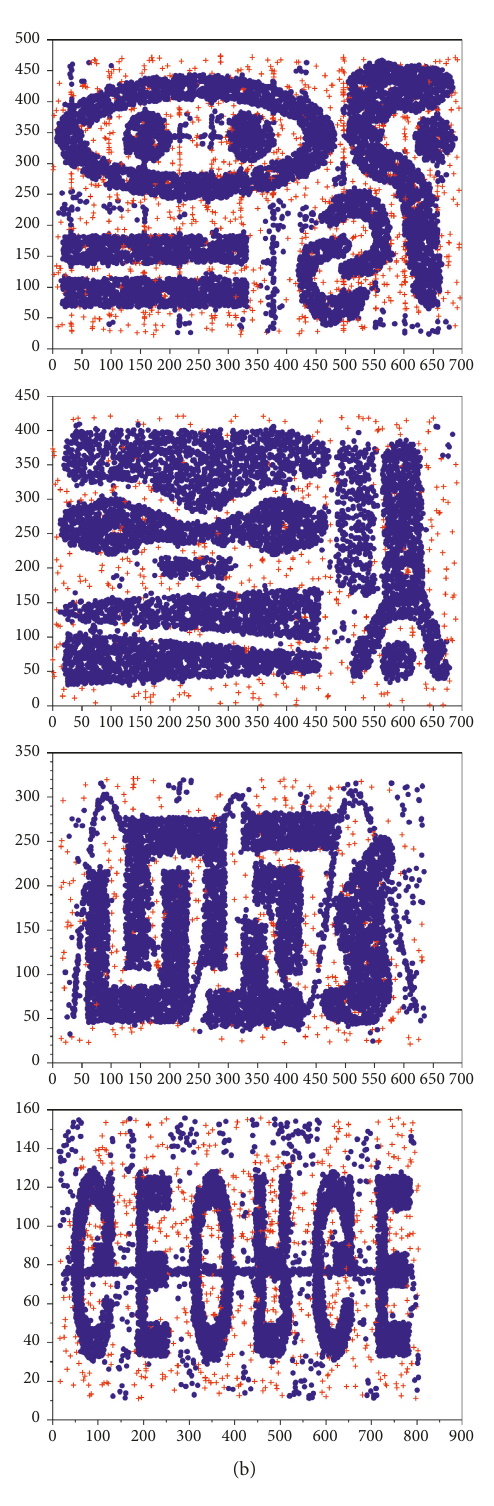
Figure 6: Results of LOF (a) and FLDS (b) on some 2D data sets: the outliers marked as red plus.